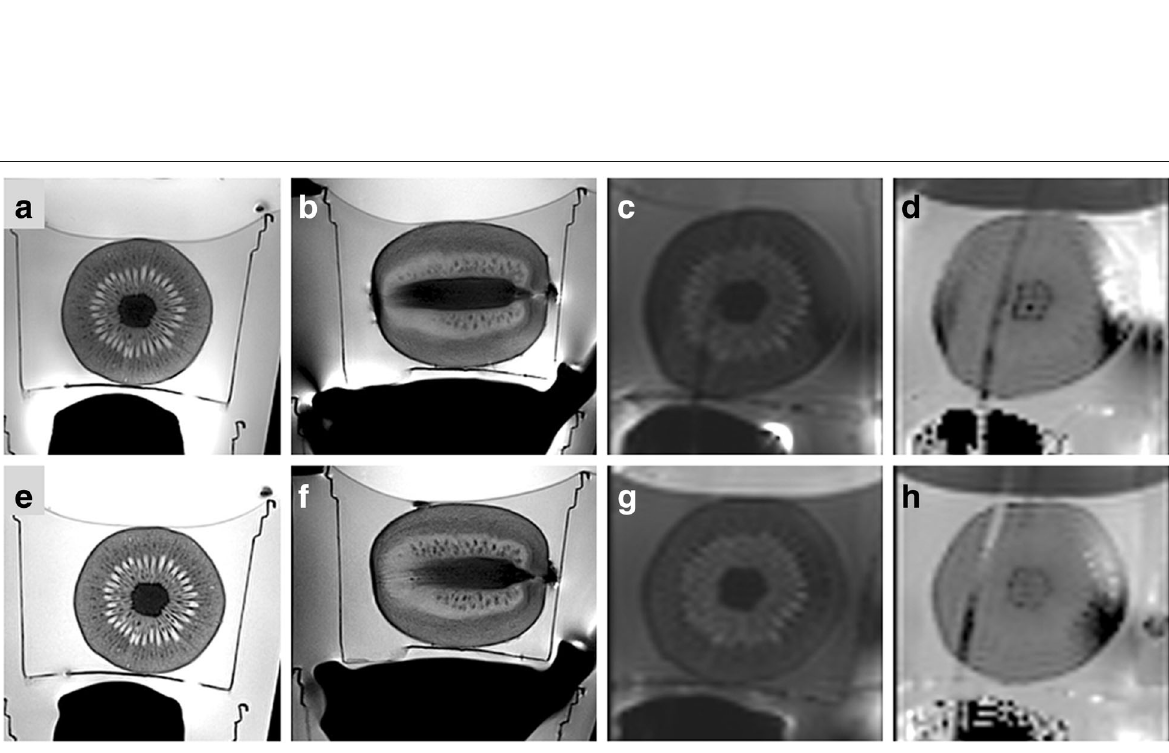
Fig. 4 Biparametric magnetic resonance imaging at 3.0 T in a green Hayward kiwifruit ( Actinidia deliciosa ) was performed at site 2 using an endorectal coil included in a multichannel phased-array coil system. Images in the upper panel ( a – d ) were obtained with air inside the endorectal coil balloon, while images in the lower panel ( e – h ) were obtained with perfluorocarbon inside the endorectal-coil balloon: axial ( a , e ) and sagittal ( b , f ) T2-weighted imaging, axial diffusion-weighted imaging with a b value of 800 s/mm 2 ( c , g ), and corresponding apparent diffusion coefficient map ( d , h ) obtained with a reduced field of